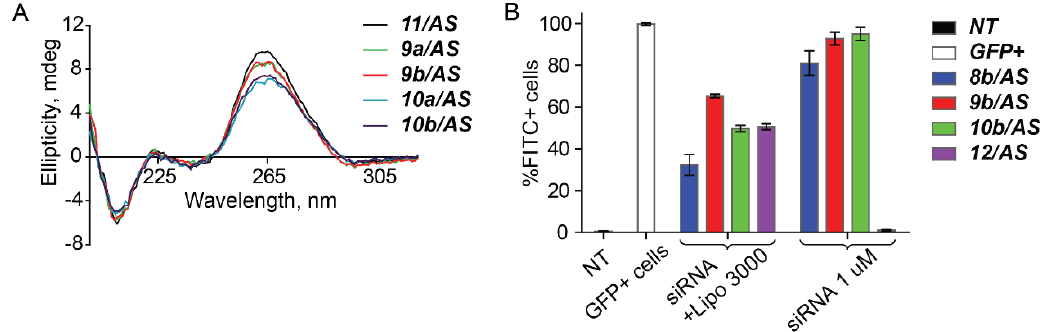
Figure 5. Modified siRNAs: ( A ) Overlay of the circular dichroism (CD) spectra of the modified siRNAs and reference unmodified siRNA, C RNA = 15 μM. Sequences: 5′-r(GCCACAACGUCUAUAUCAU)dTdT-3′ ( 11 ), M w calculated 6573.1, found ( m / z ) [M + H] + 6574.4; 5’-r(AUGAUAUAGACGUUGUGGC)dTdT-3’ ( AS ), M w calculated 6711.1, found ( m / z ) [M + H] + 6714.9. ( B ) Flow cytometry data analysis: a bar graph showing the percentage of fluorescent (fluorescein channel) living cells observed after 4 h of transfection by fluorescein-labeled siRNAs (Table 3). Data are presented as medians obtained from 3 independent experiments.